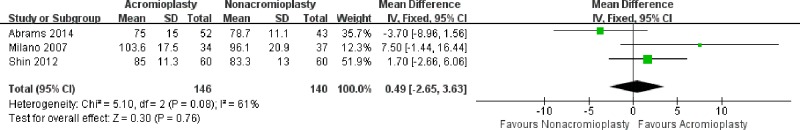
Forest plot of constant score between the treatment of acromioplasty and nonacromioplasty.